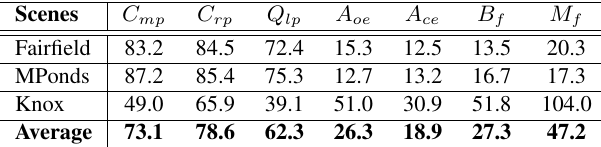
Table 2: Pixel-based evaluation results in percentages ( C mp = completeness, C rp = correctness, Q lp = quality, A oe = area omis- sion error, A ce = area commission error, B f = branching factor and M f = miss